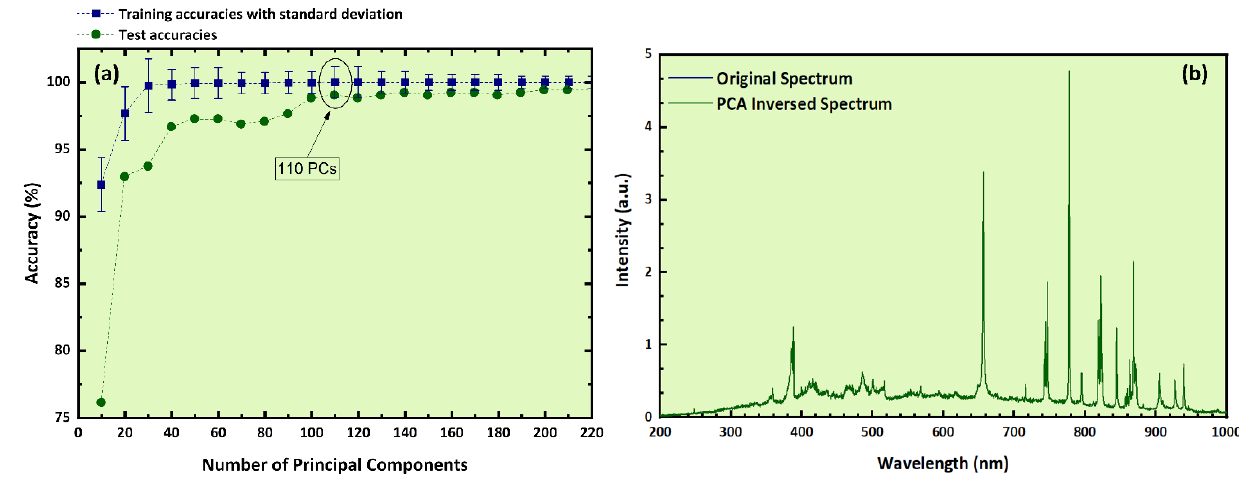
Figure 4. ( a ) Training and test accuracies as a function of the number of PCs, ( b ) experimental LIBS spectrum and PCA-inversed spectrum.